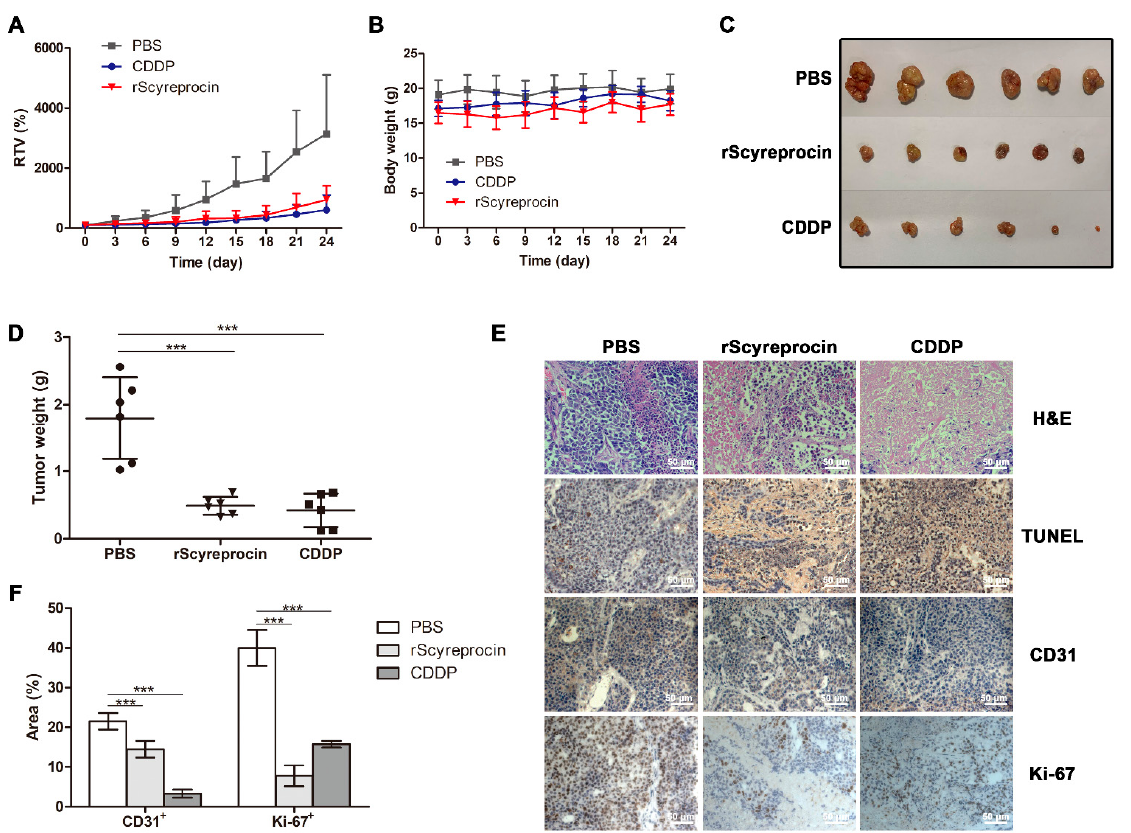
Figure 7. Recombinant scyreprocin (rScyreprocin) suppressed tumor growth in vivo. ( A ) Relative tumor volume (RTV) in different treatment groups. Cisplatin (CDDP, 3 mg kg − 1 ), rScyreprocin (1.8 mg kg − 1 ), and PBS (control) were given by intratumor injections; tumor volumes were measured